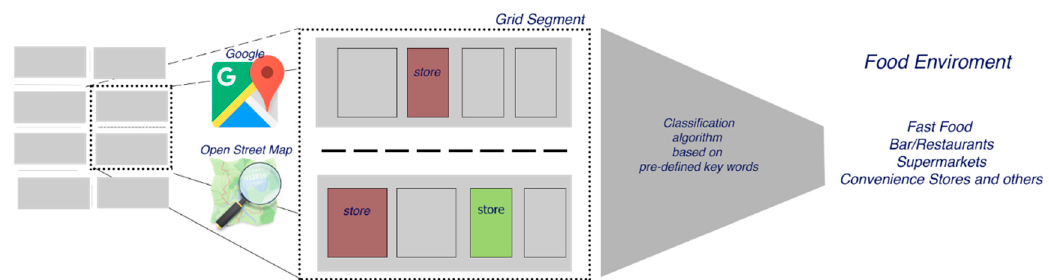
Figure 1. Facility list coder workflow (FLC). The diagram shows the steps performance for the FLC to